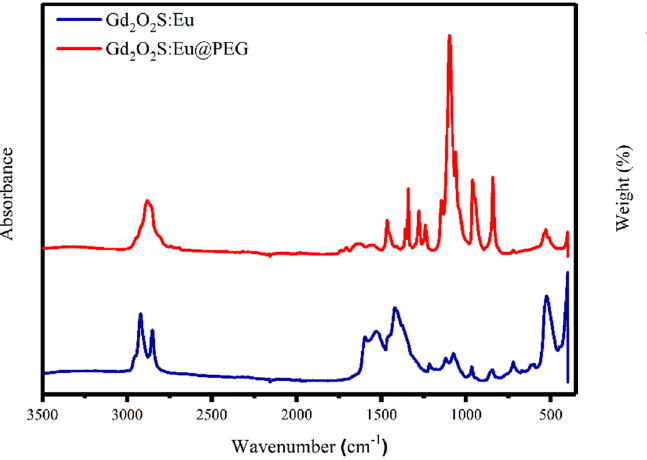
Figure 4: Thermogravimetric analysis of Gd 2 O 2 S:Eu before and after modi fi